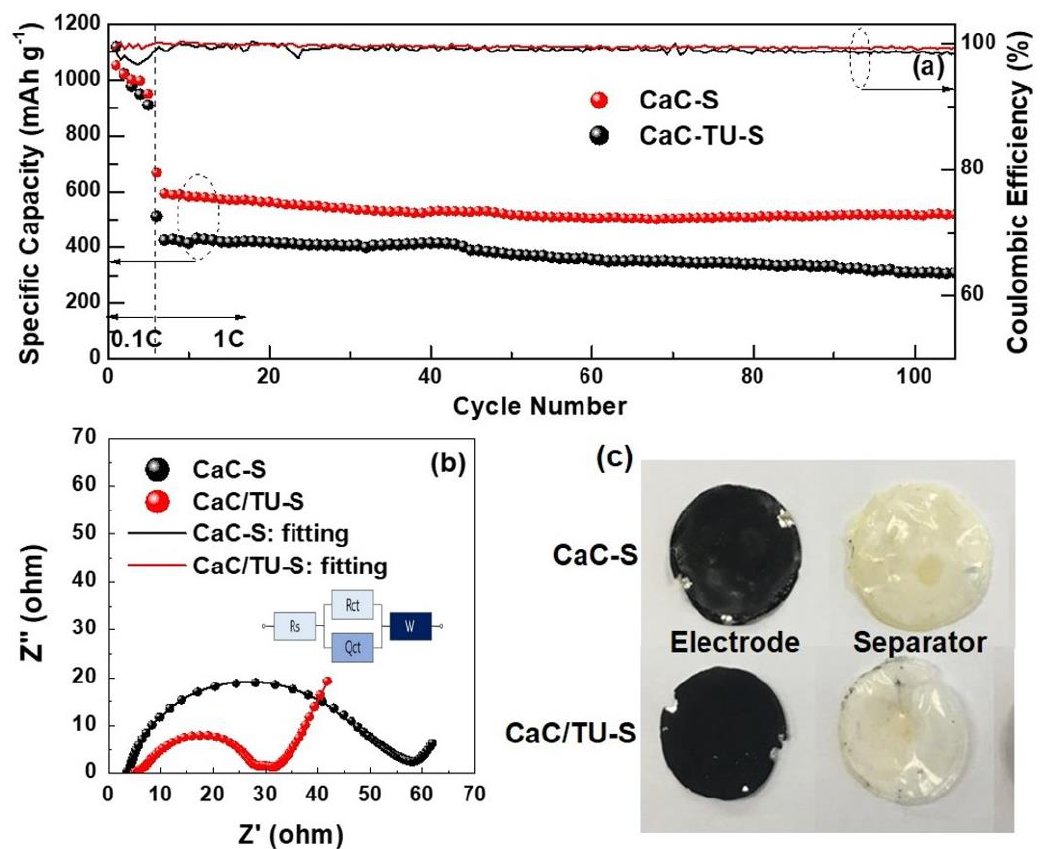
Figure 7. ( a ) Cycling performance of the CaC-S and CaC / TU-S cells; ( b ) Nyquist plots of cycled cells; and ( c ) Photographs of electrode, polypropylene (PP) separator, and Li metal of cycled cells disassembled in fully charged state after the initial 100 cycles.